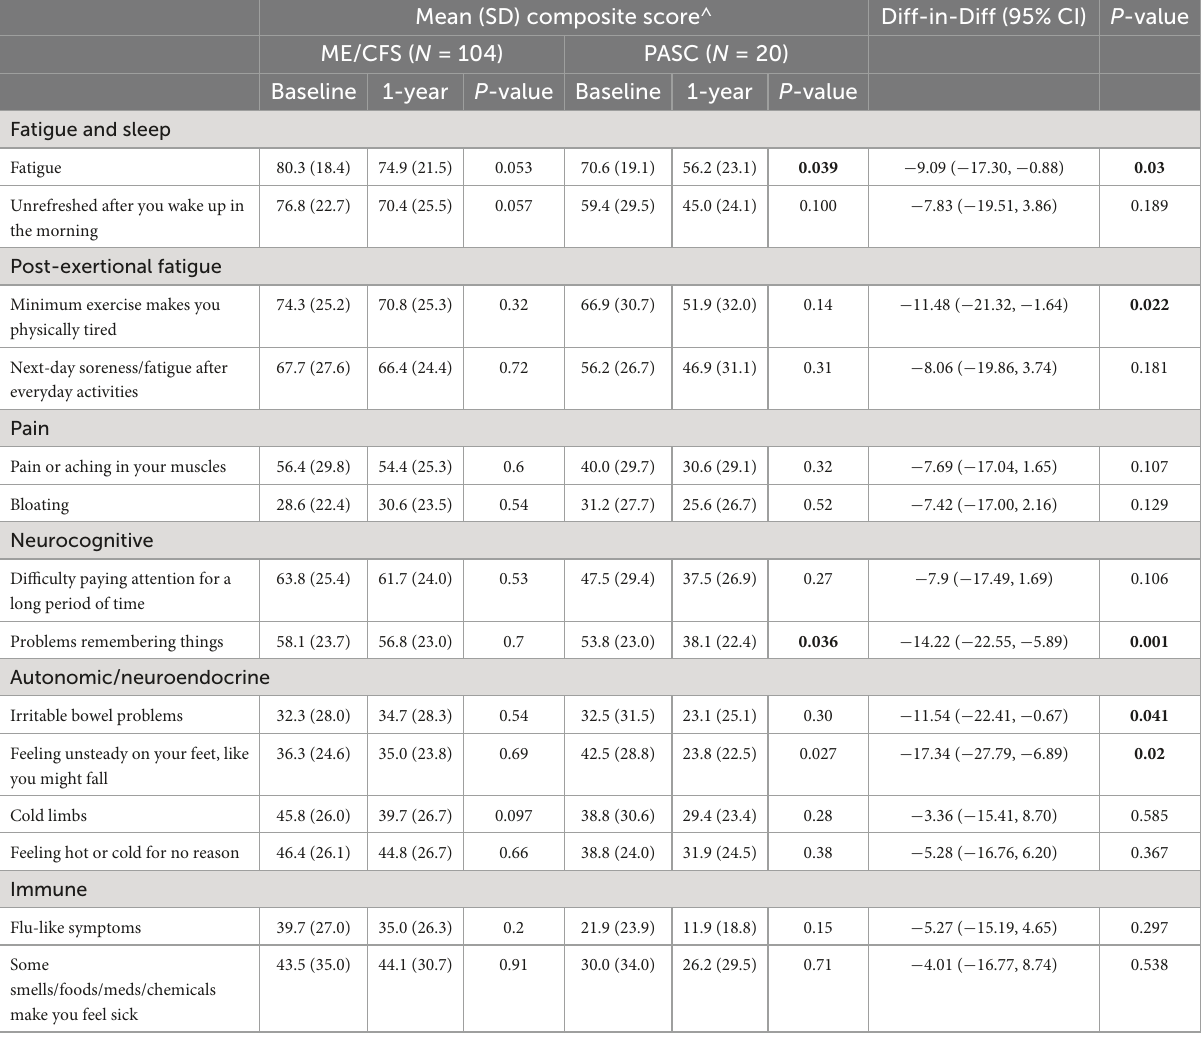
TABLE 3 Differences in mean composite scores between baseline and 1-year